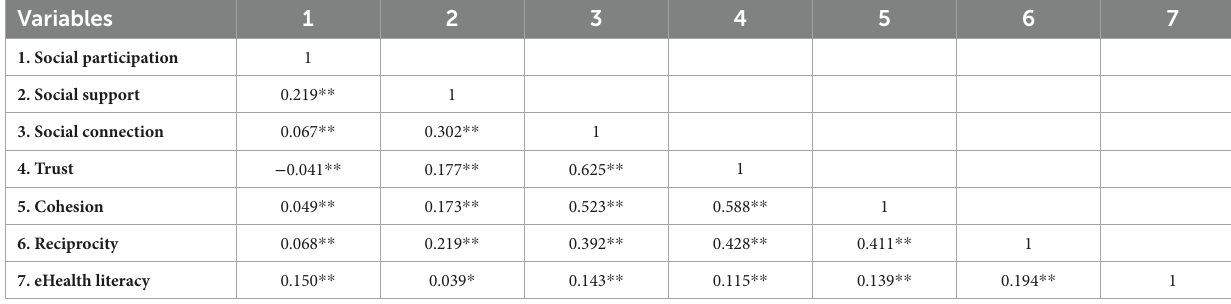
TABLE 2 Correlation of included variables and eHealth